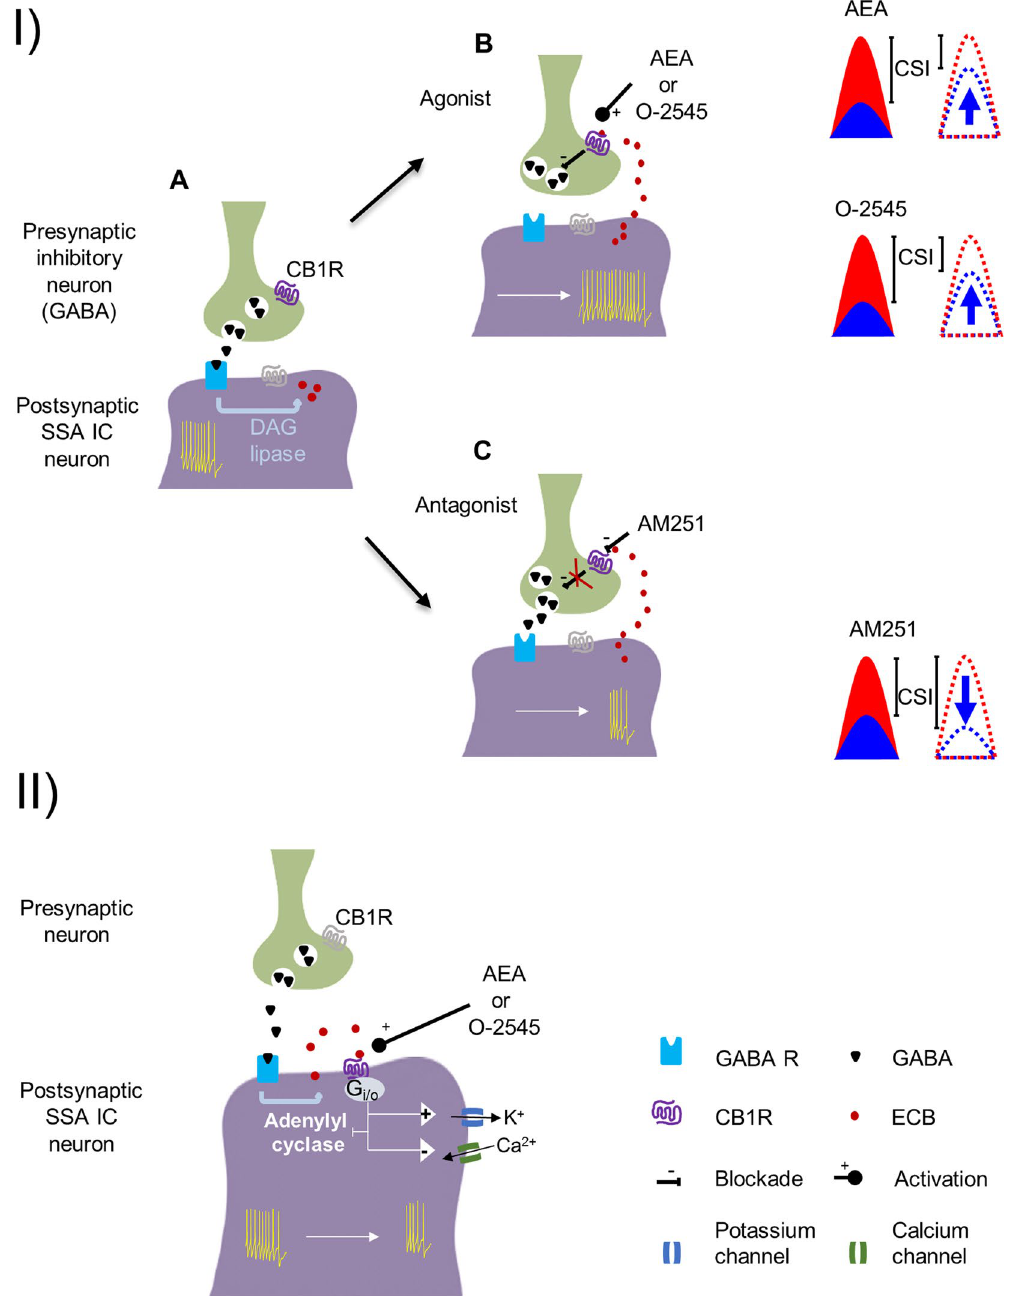
Figure 6. Schematic representation of hypothetical action mechanisms of cannabinoids on IC neurons that exhibit SSA. ( I .A) An inhibitory input (probably GABAergic, green) contacting a postsynaptic IC neuron (purple). Basal activity is shown as action potentials (yellow) in the postsynaptic neuron. GABA release affects the activity of the neuron by acting on postsynaptic receptors. ( I .B) Agonist drugs that activate presynaptic CB1R on the inhibitory terminal lead to an increase in the firing rate of the postsynaptic neuron due to a decrease in the GABA release. Both agonists produce an increase of the firing rate in response to the standard frequency; thus, the CSI of the postsynaptic SSA IC neuron decreases. We cannot rule out the possible involvement of other neuromodulatory substances in the final result. ( I .C) Injection of the CB1R antagonist AM251 producs a blockade of the basal ECB and/or the constitutive activity of the receptors, hence GABA is released, decreasing the firing rate for standard stimuli that results in a CSI increase. ( II ) If CBRs are located in the postsynaptic neurons, their activation should promote both an inhibition of adenylyl cyclase, and a change in the open probability of ionic channels (K + and Ca 2 + ) that would lead to a decrease in neuronal